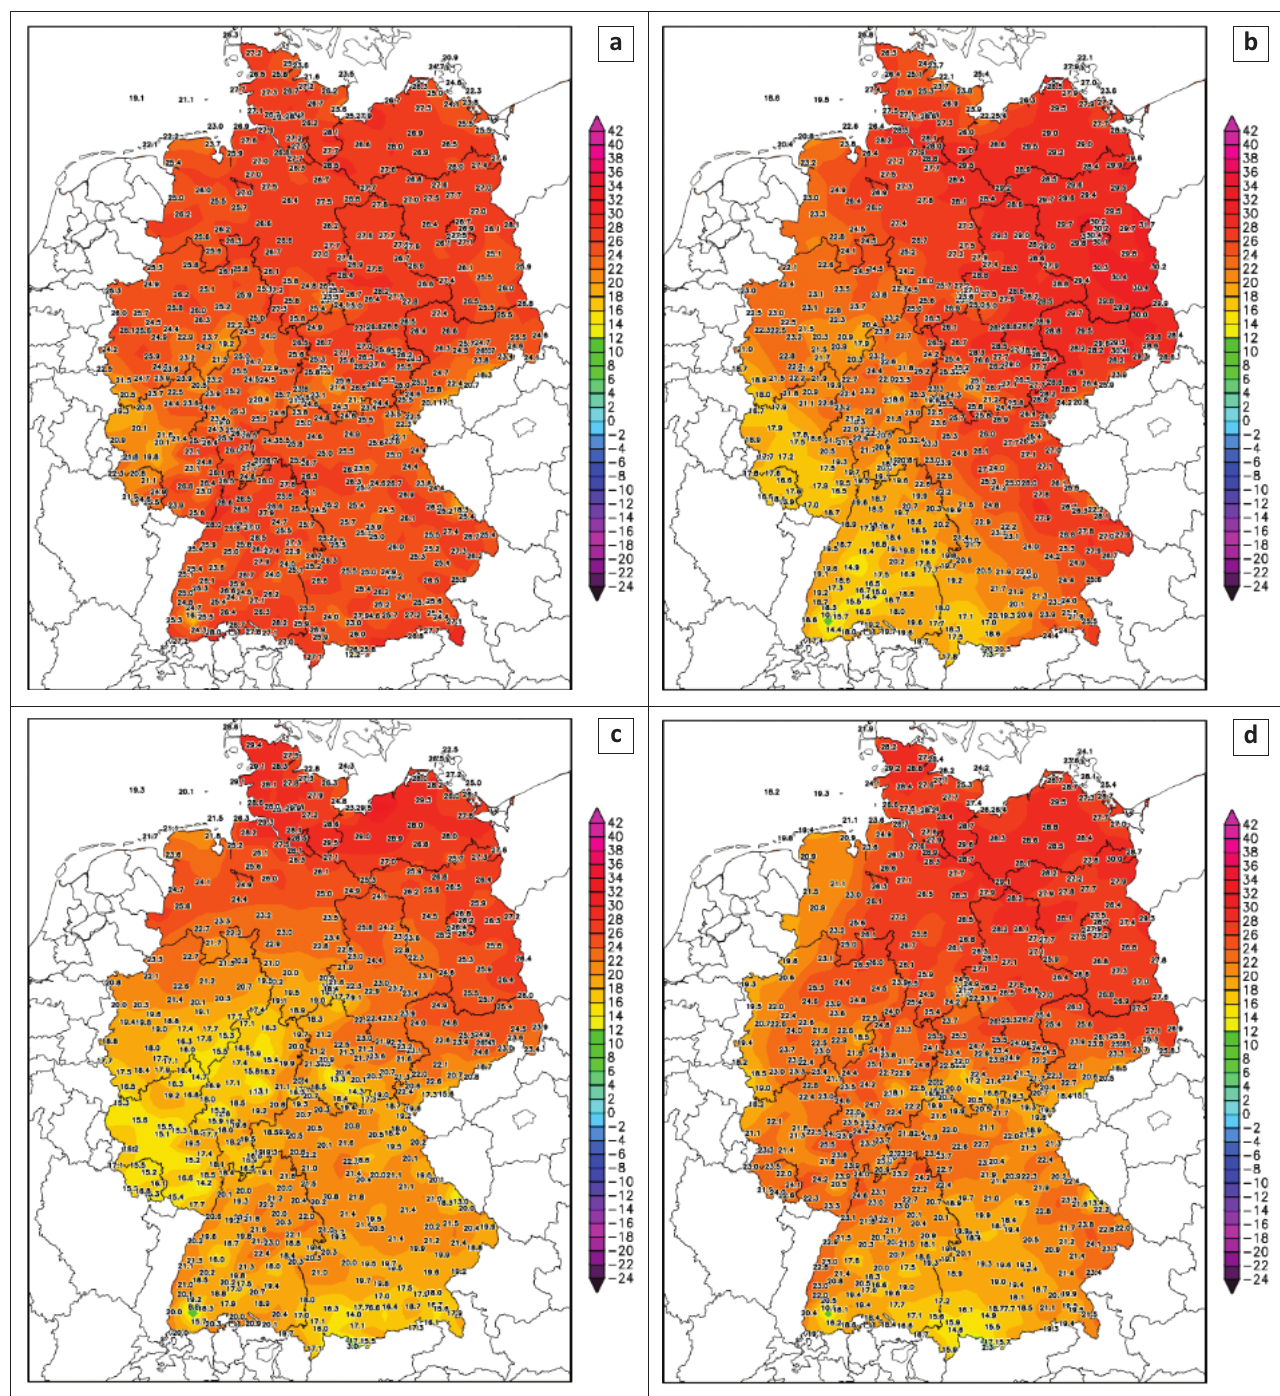
FIGURE 2: Maximum temperature across Germany during the days of floods: (a) 12 July 2021, (b) 13 July 2021, (c) 14 July 2021 and (d) 15 July